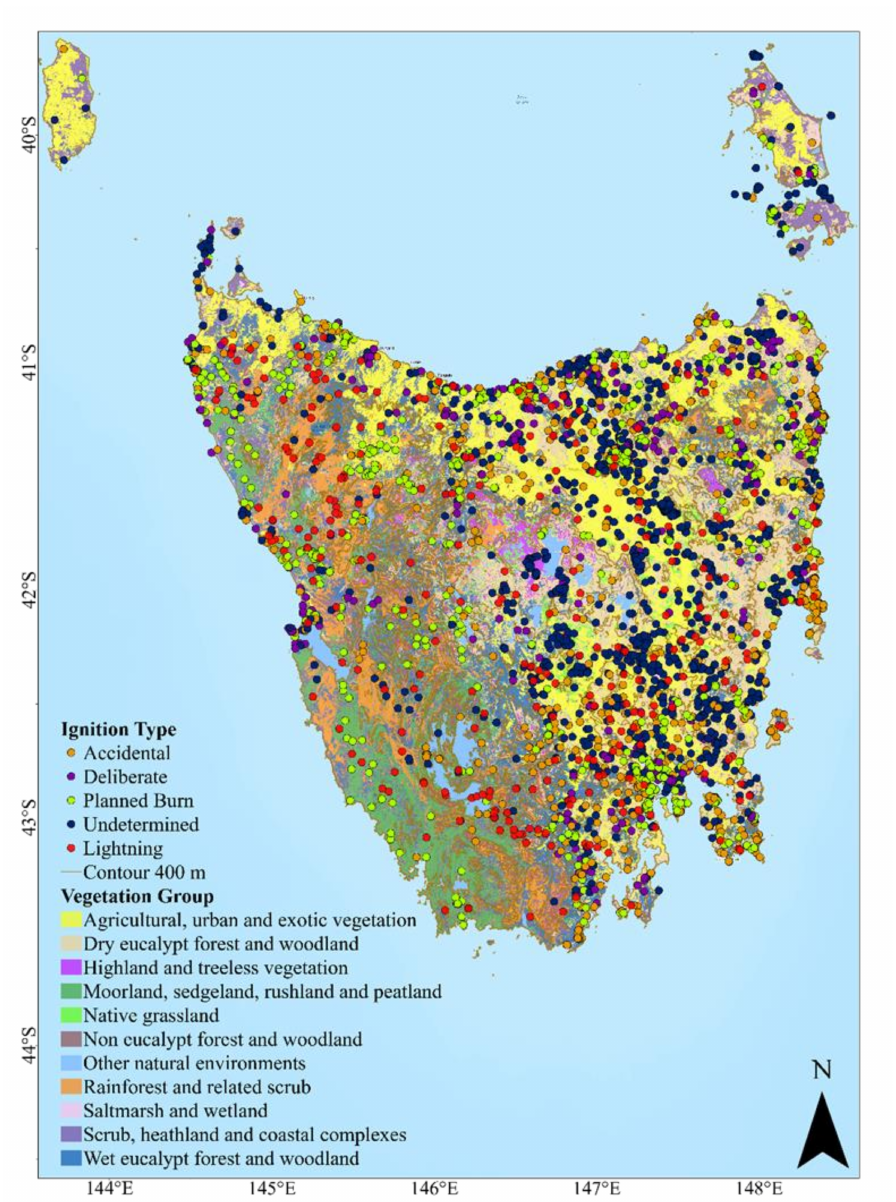
Figure 1. Topographic map of Tasmania (400-m contour lines) showing ignition types (accidental, deliberate, planned burn, undetermined and lightning-induced) and locations between 2011 and 2019. The major vegetation groups distributed over the study area are